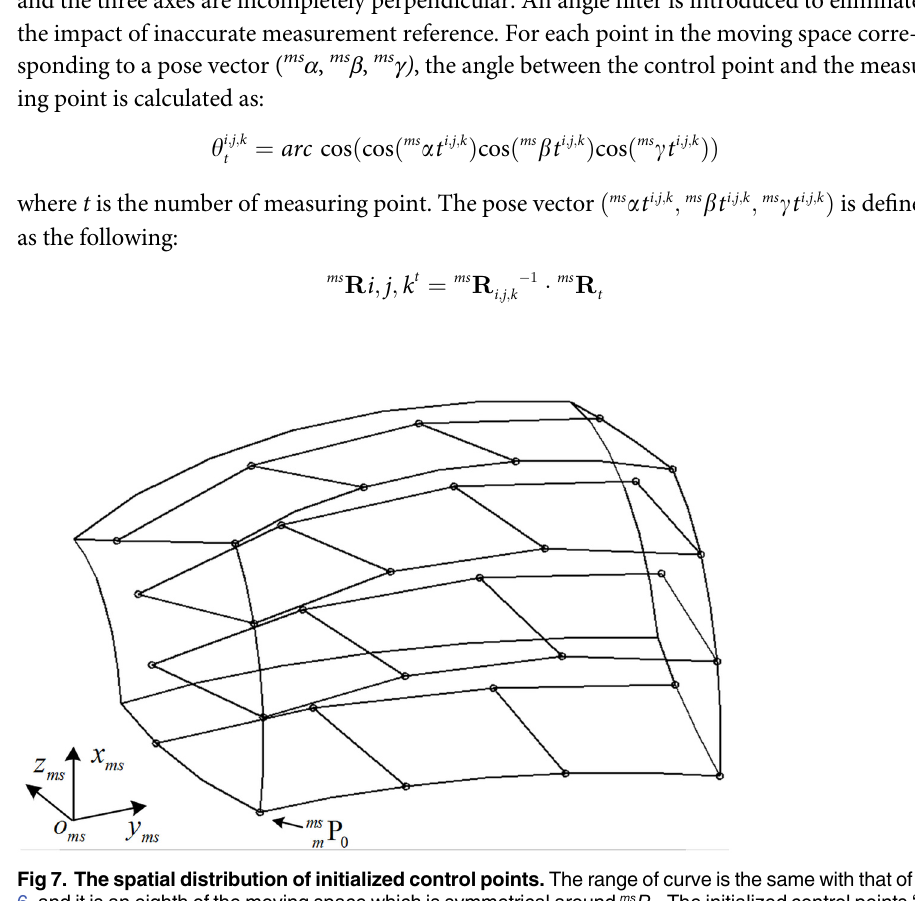
P 0 . The initialized control points ‘ (cid:5) ’ m